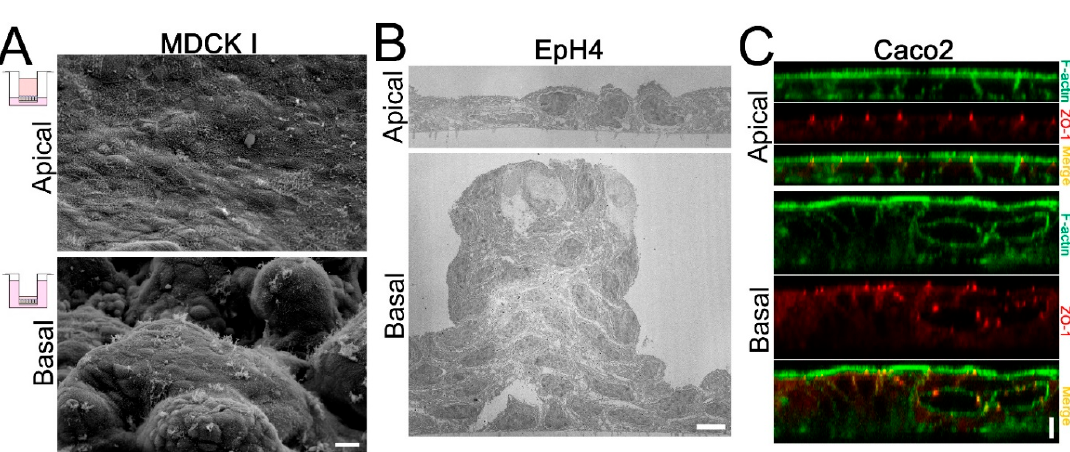
Figure 3. E ff ects of the HP gradient on carcinogenic properties of epithelia. ( A ) Scanning electron micrographs in MDCK I cells. 0.6 cmH 2 O HP was applied from apical or basal side for four days. A bumpy surface with cell masses was observed when the HP was applied from a basal side. Scale bar = 10 µ m. ( B ) Transmission electron micrographs in EpH4 cells. 0.6 cmH 2 O HP was applied from apical or basal side for four days. HP from a basal side induced stratification. Cavities were observed within the stratification. Scale bar = 5 µ m. ( C ) Immunofluorescence of F-actin and ZO-1 in Caco2 cells. 0.6 cmH 2 O HP was applied from apical or basal side for eight days. HP from a basal side induced stratification. ZO-1 was localized at the cavities within the stratification. Scale bar = 5 µ m. Modified from Tokuda et al., PLoS ONE. 2015 [113] with permission.